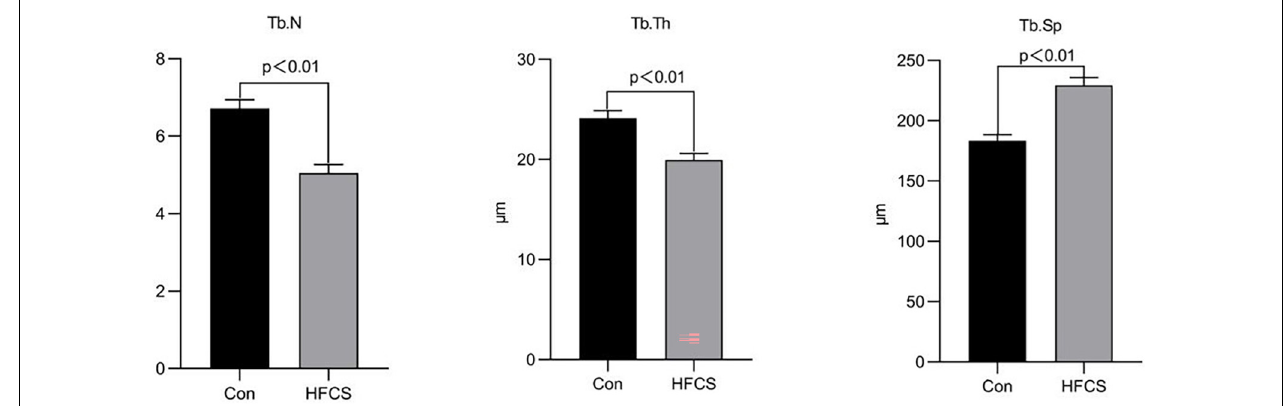
FIGURE 3 | Effects of HFCS on the Tb.N, Tb.Th, and Tb.Sp in mice. Tb.N, trabecular number per mm; Tb.Th, trabecular thickness; Tb.Sp, trabecular separation. All data was expressed as mean ± SEM ( n = 8) and analyzed by one-way ANOVA analysis.